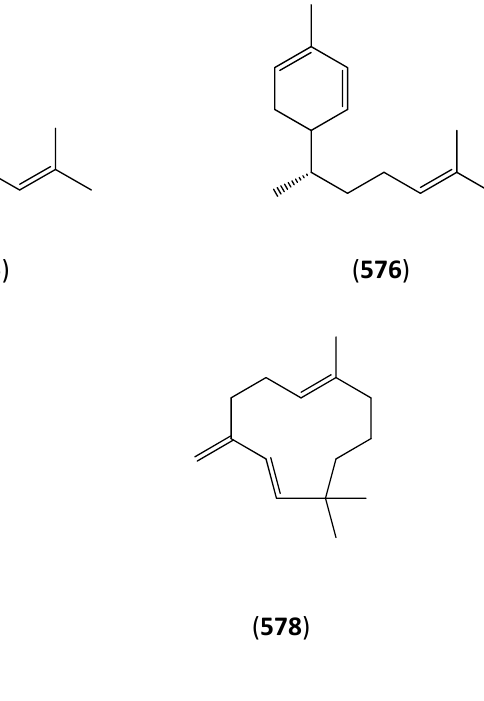
Figure 3. Minor products from the cyclization of FPP ( 378 ) by ADS, which have not